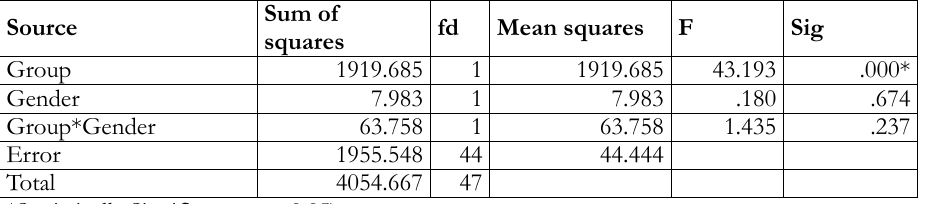
Table 2. Results of ANCOVA of the experimental group and the control in the